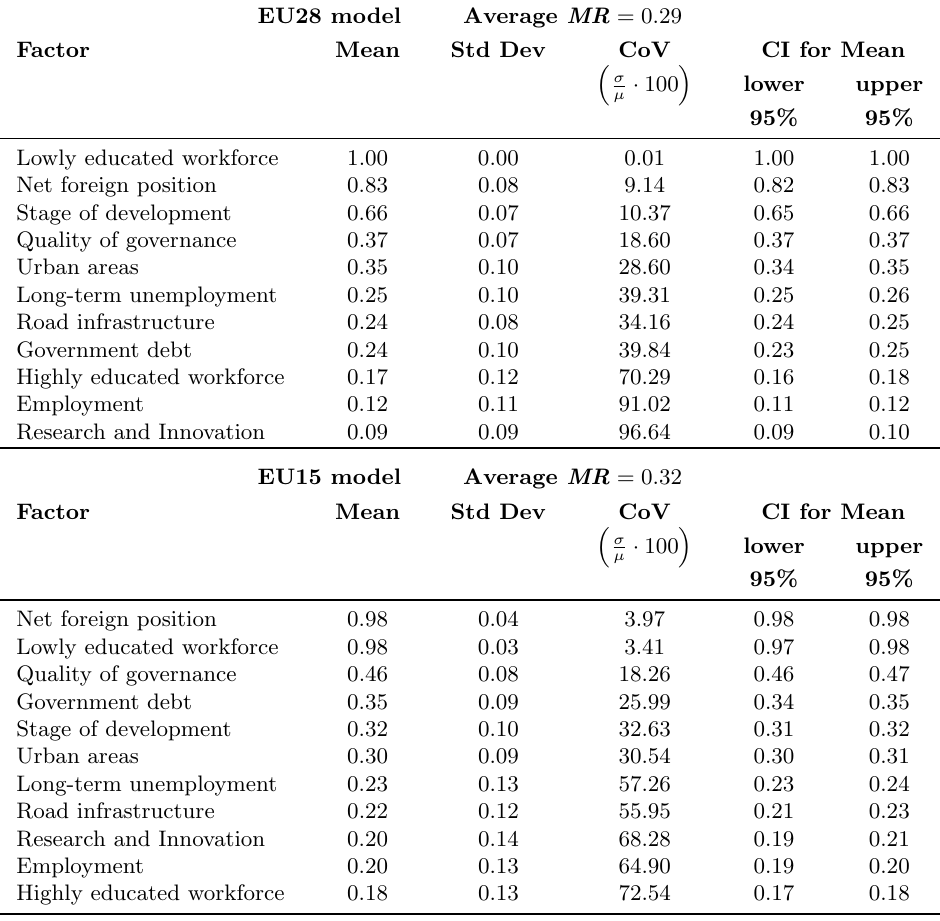
Table 2: CART results: Variable ranking based on their average normalized impor- tance(from 1000 randomized